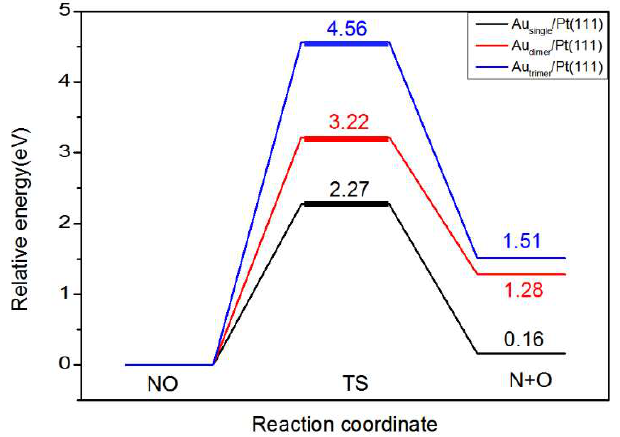
Figure 6. Decomposition potential energy diagram of NO on Au single /Pt(111), Au dimer /Pt(111), and Au trimer /Pt(111) surfaces.